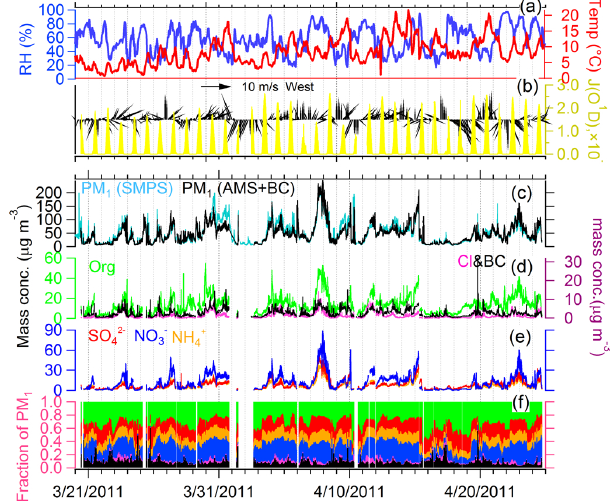
Fig. 1. Time series of (a) relative humidity (RH) and temperature (Temp) at the Changdao site; (b) Time series of local wind direction and speed (left axis) as well as J (O 1 D) values (right axis); (c) Time series of PM 1 concentrations calculated from SMPS volume con- centrations (15–600nm) and from AMS species + BC. Temporal particle density calculated by the main chemical composition of particle measured by AMS and is applied to the calculation of PM 1 mass concentrations from SMPS. The density varied from 1.3–1.6 with an average value of 1.5gcm − 3 . (d) Time series of organics (left), chloride and BC (right). (e) Time series of sulfate, nitrate, and ammonium. (f) The fractions of AMS species and BC in PM 1